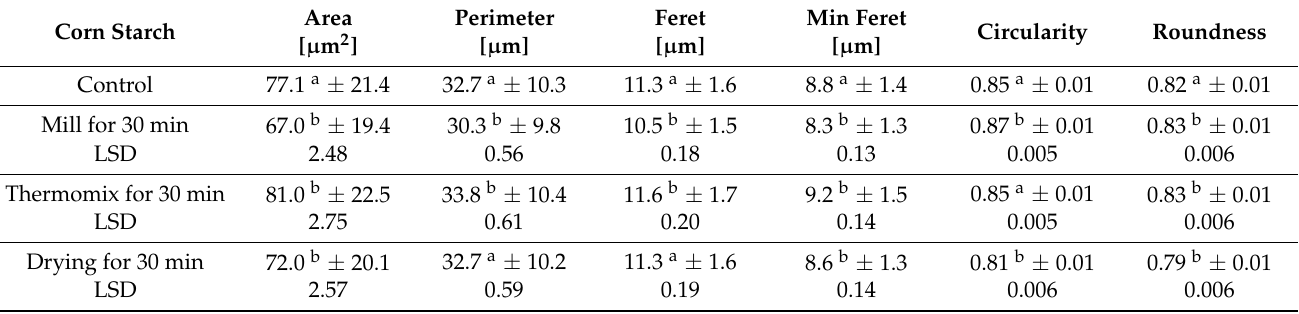
Table 3. Comparison of measurements of corn starch granules before (control) and after grinding and drying.